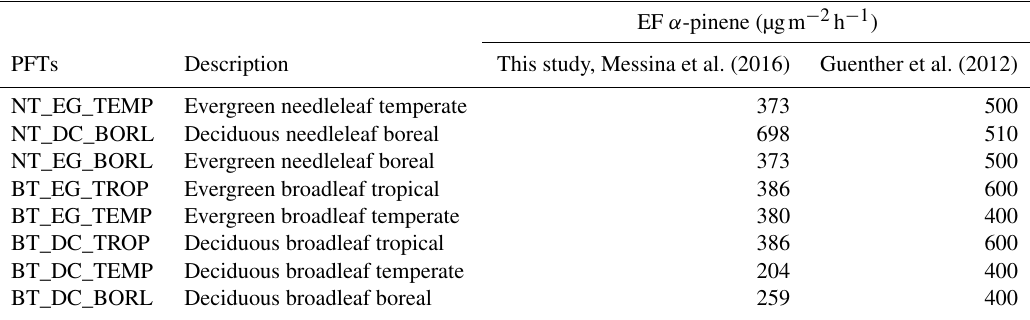
Table 2. Updated emission factors for α -pinene (µgm − 2 h − 1 ) for tree PFT classes used in this study based on Messina et al. (2016) together with original MEGANv2.1 EFs (Guenther et al.,